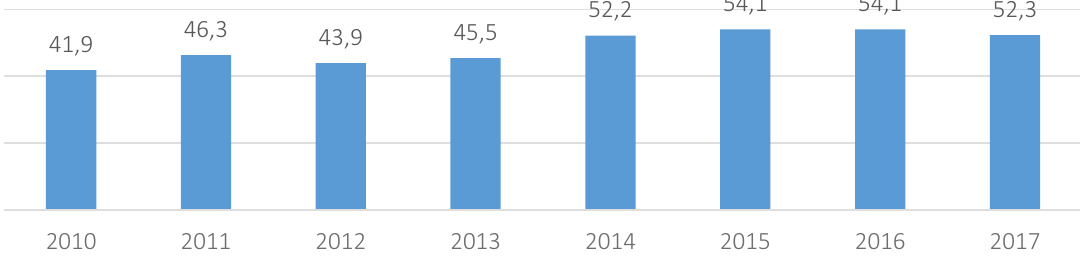
Figure 10. Out-of-pocket expenditure (% of current health expenditure), Ukraine, 2010–2017